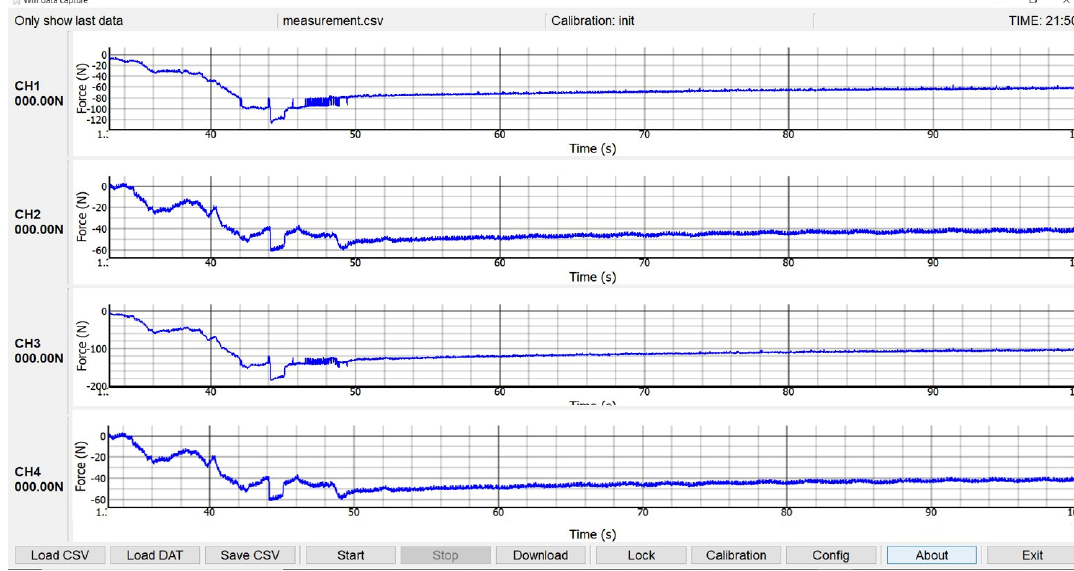
Figure A1. GUI designed for the monitoring application.